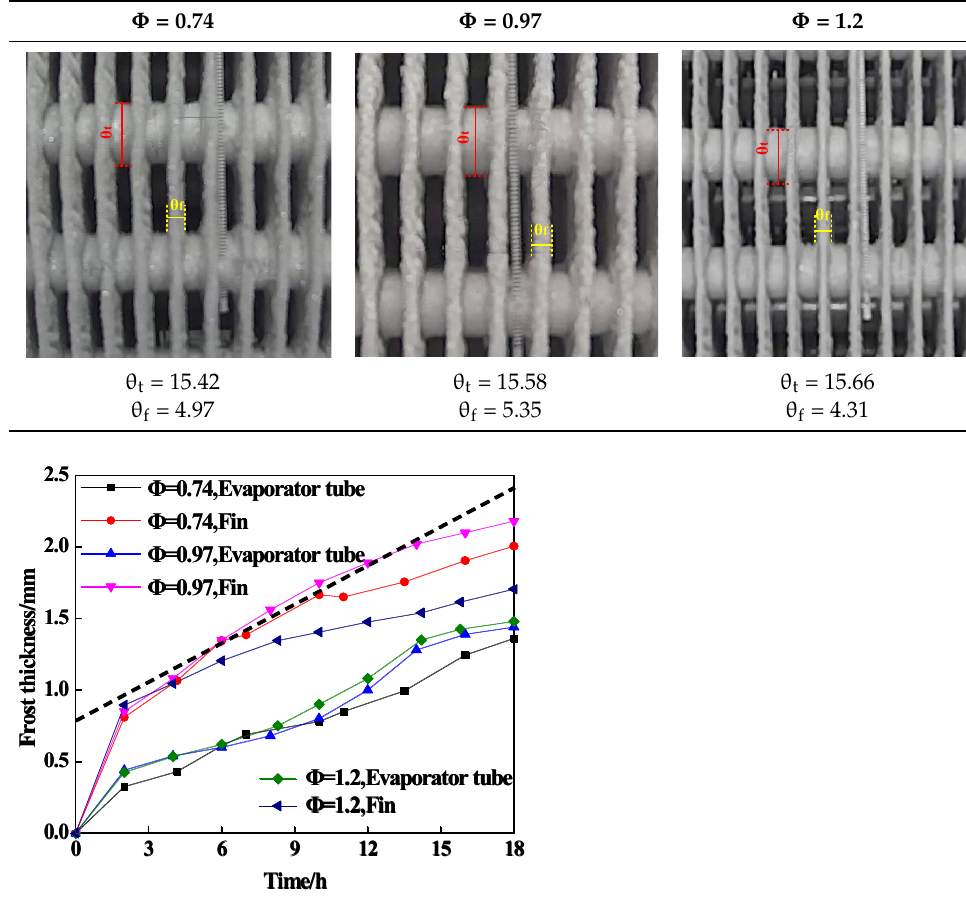
Figure 7. Comparison of frost thickness at point 5 under different plenum-chamber coefficients.